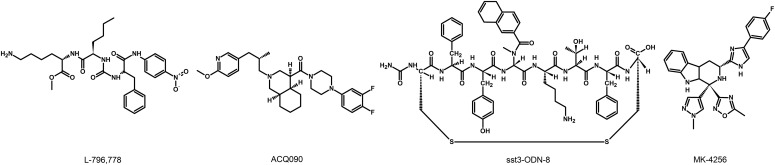
Structures of synthetic SST3 ligands. L-796,776, SST3 agonist; ACQ090, sst3-ODN-8, and MK-4256, SST3 antagonists.